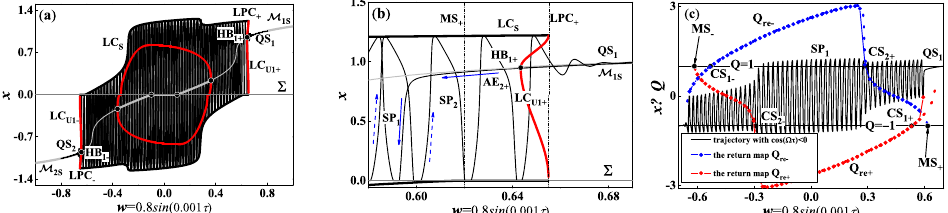
Figure 6. Mechanism analysis of bursting oscillation in Figure 5a: ( a ) slow–fast analysis via overlapping the bursting oscillation and one parameter bifurcation diagram in Figure 3a; ( b ) enlarged drawing of Figure 6a; ( c ) non-smooth oscillation modes in spiking state SP 1 are illustrated via return maps. Since the spiking states SP i ( i = 1, 2 ) are formed by the trajectories oscillating along with the spiking attractor LC S , sliding bifurcations presented in Figure 3b unavoidably affect the oscillation structures of the two spiking states, leading to the fact that the four nonsmooth oscillation modes in Figure 4 may be observed, as shown in Figure 6c. By drawing the returning maps Q re ± of spiking state SP 1 , the spiking state SP 1 actually behaves in unique mixed oscillation modes via performing nonsmooth oscillation mode series: single sliding −→ double sliding −→ crossing sliding −→ double sliding −→ crossing sliding −→ double sliding −→ single